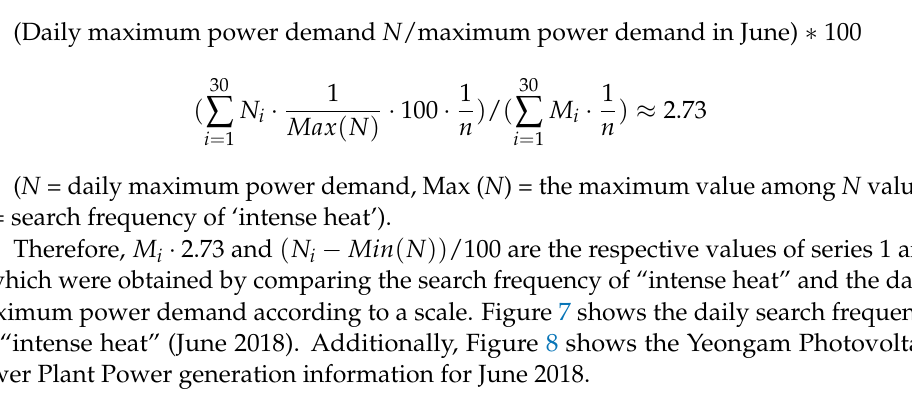
Figure 6. Daily search frequency for “intense heat” (June 2018).